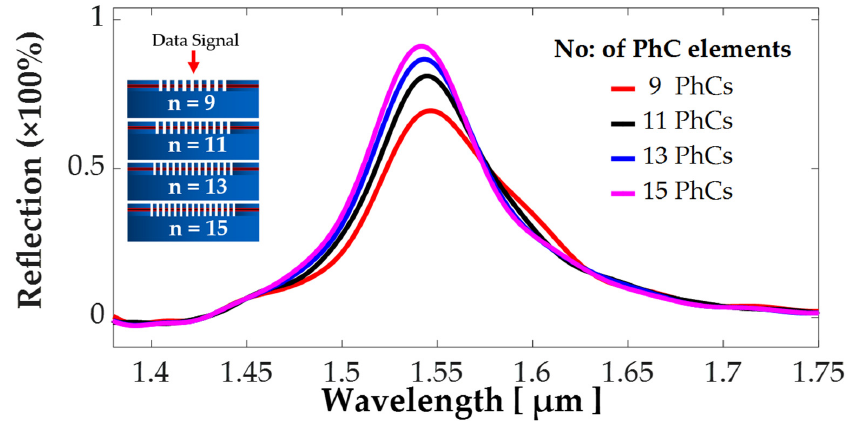
Figure 5. The reflection spectrum of PhC structure for variation in the number of periods of PhC- elements for the data signal.